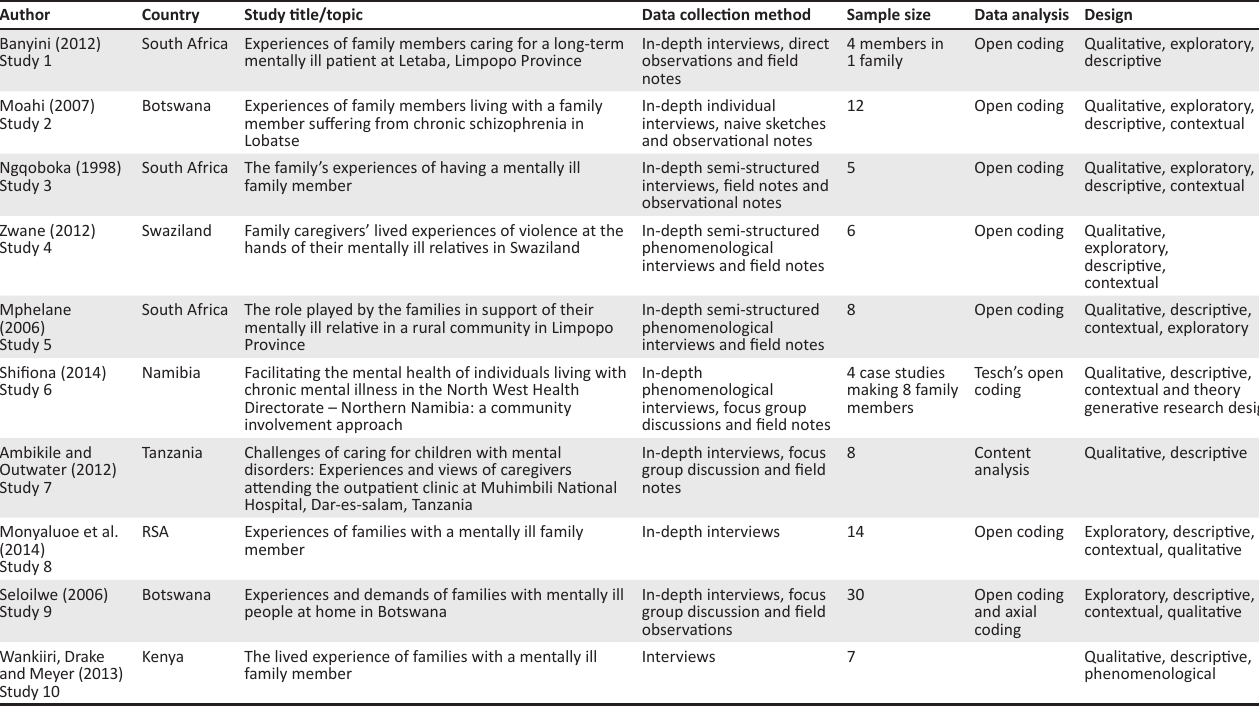
TABLE 1: Characteristics of reviewed studies included in the